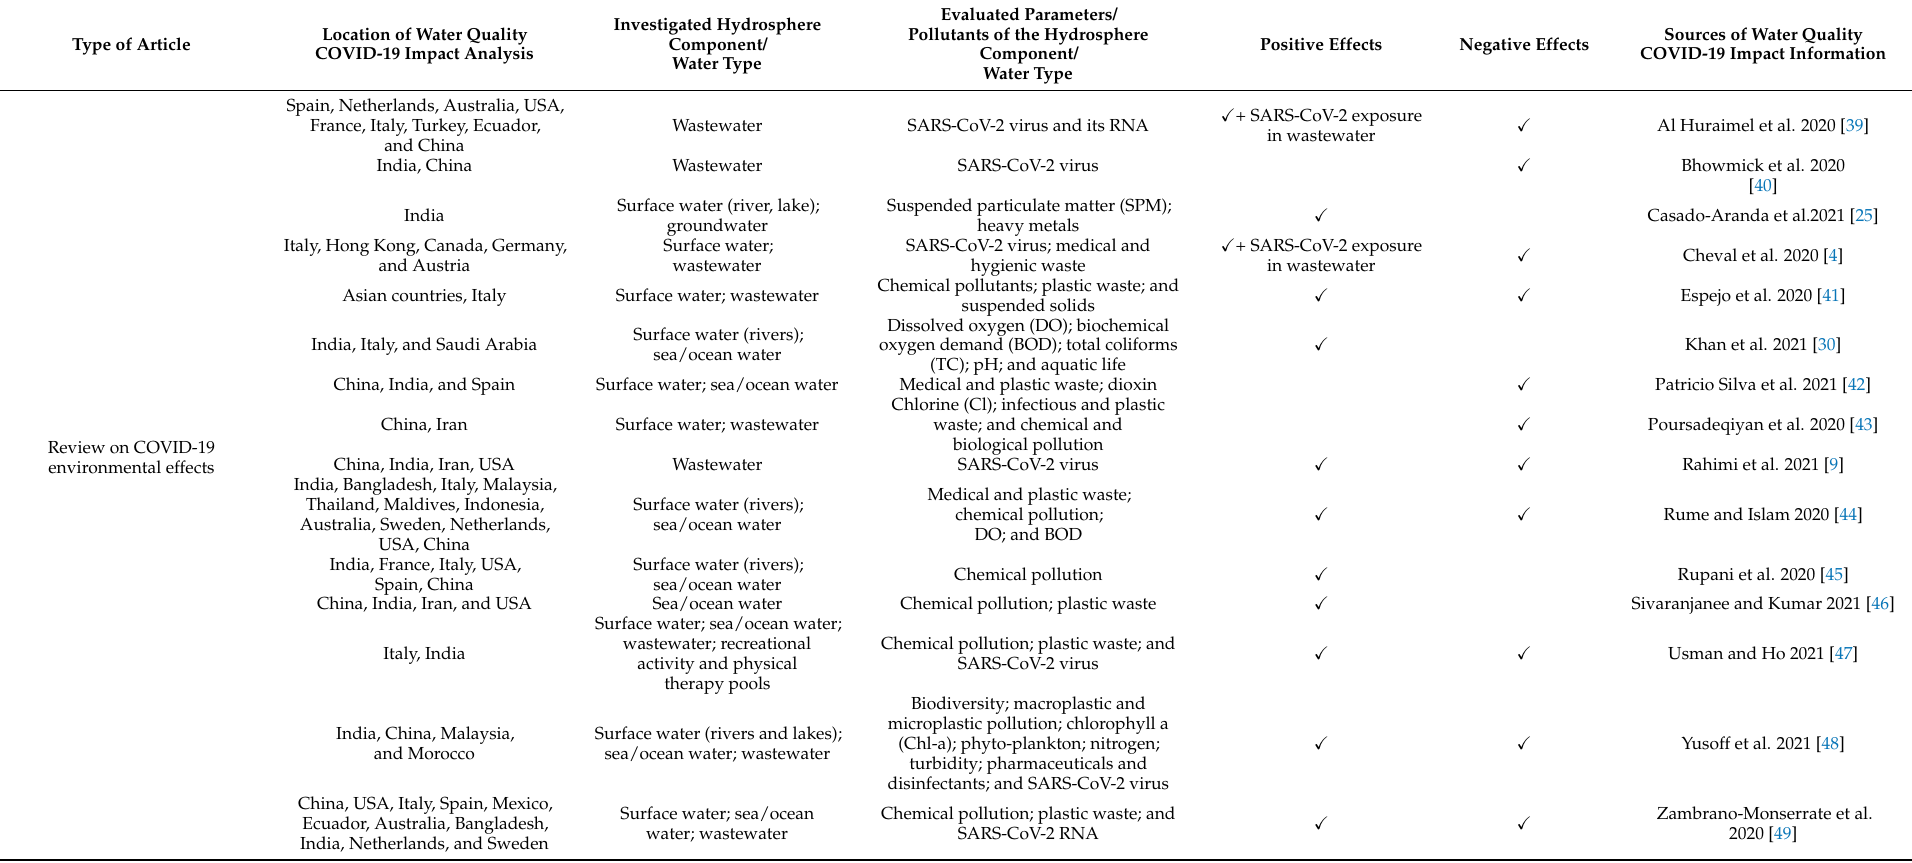
Table 1. The WoS platform review process results on COVID-19 impact on water